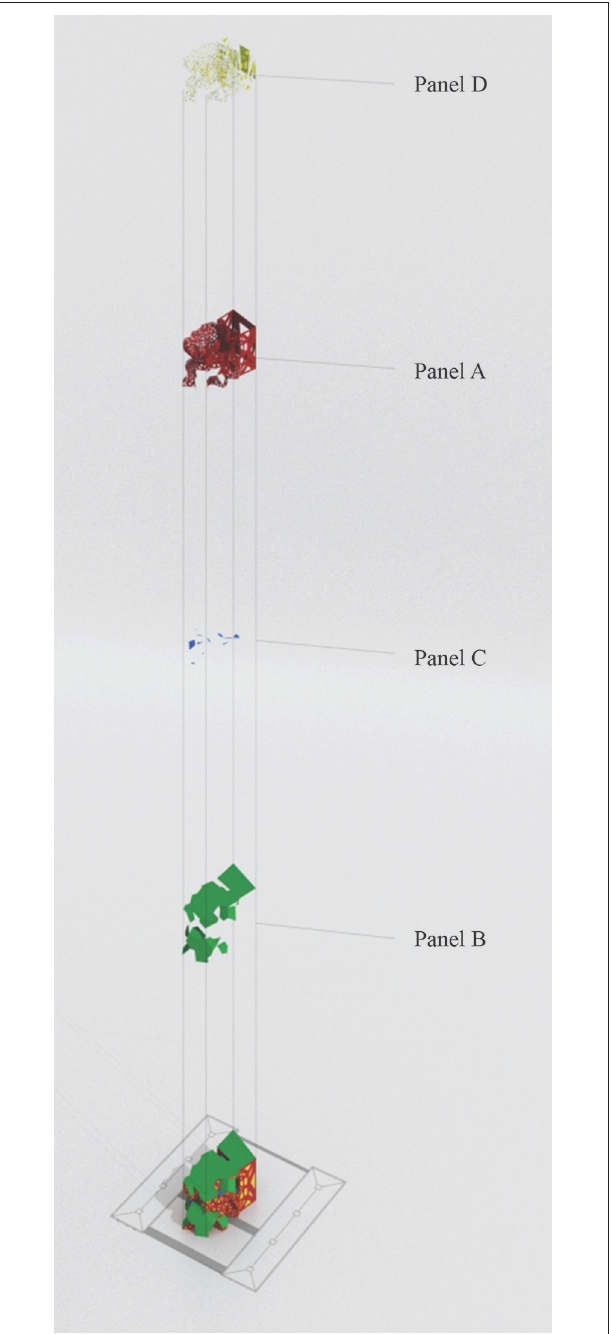
FIGURE 14 | Exploded diagram showing the final combination of element